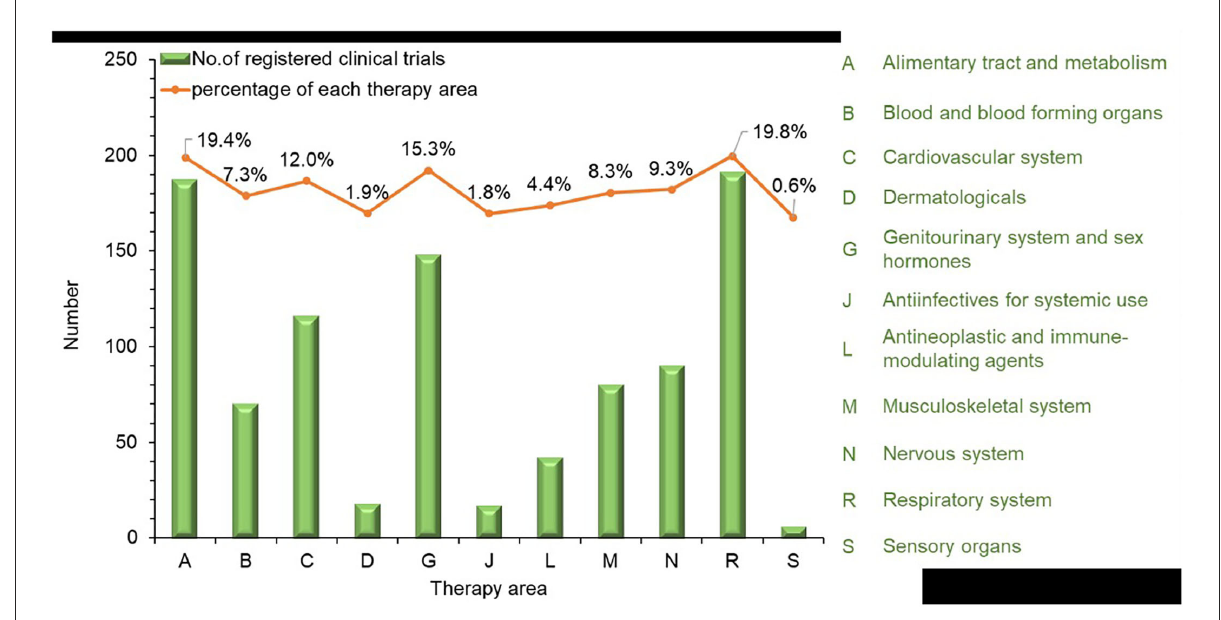
FIGURE4 Therapy area distribution of TCM trials registered from 2013 to 2021 in mainland China.